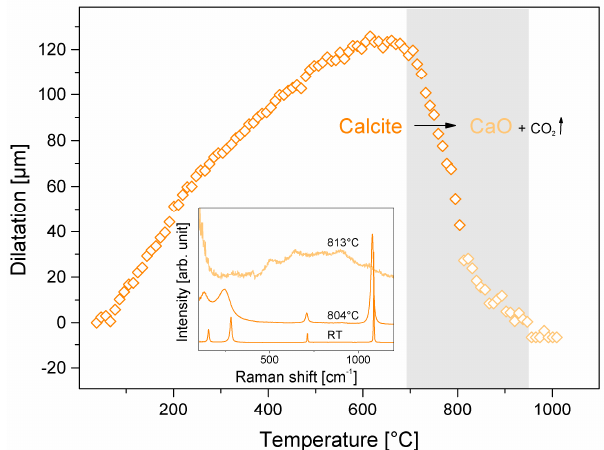
Figure 1. Dilatation of a pellet composed of calcite powder as a function of temperature. The dilatation was measured during the automated measurements by depth profiling. Note the dramatic shrinkage above 740 °C due to the decarbonation of calcite. The decarbonation is taking place between 700 and 950 °C, which can be followed by the shrinkage of the sample. At 804 °C, the calcite bands broaden and are shifted to lower wavenumbers (inset). Above 813 °C, calcite at the sample surface is fully decomposed to CaO (lime) that only shows a second order Raman spectrum. Note that the Raman spectra were recorded at the sample surface.